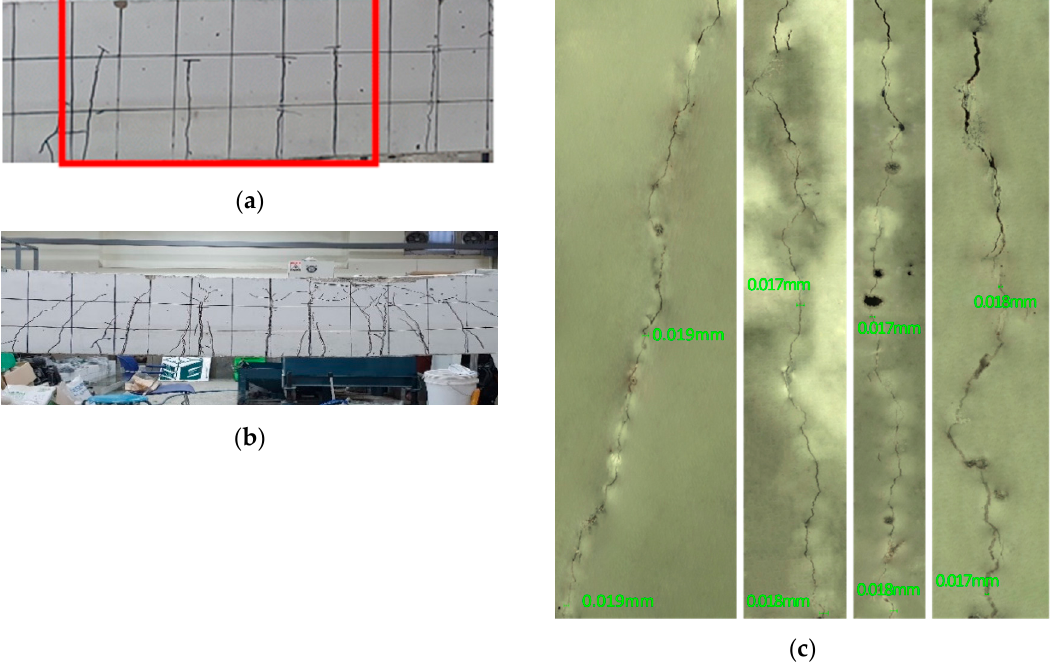
Figure 22. Crack healing of member RL_28 + 90D-2.5: ( a ) after pre-loading at 28 days + 90 days of additional curing; ( b ) after loading at 28 + 90 days; ( c ) enlargement of cracks after completion of test.